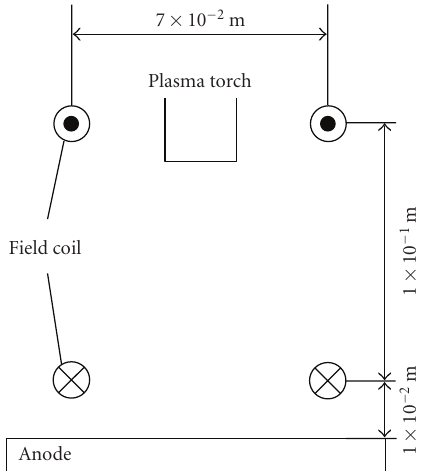
Figure 4: Dimensions of the magnetic field